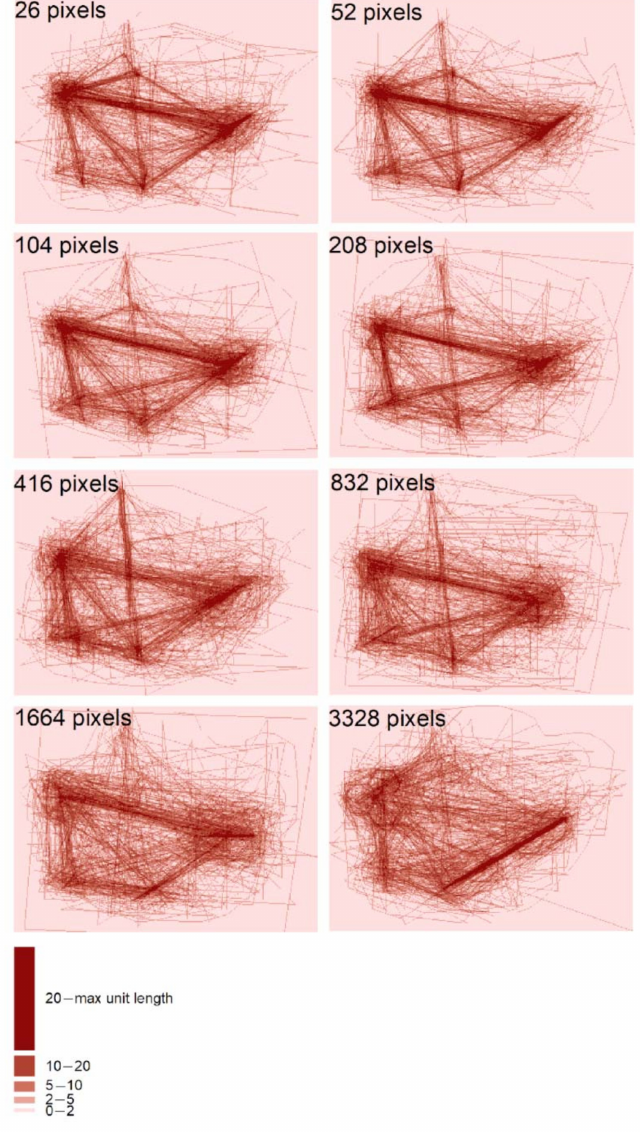
Figure 9. Results of T6 vectorization task